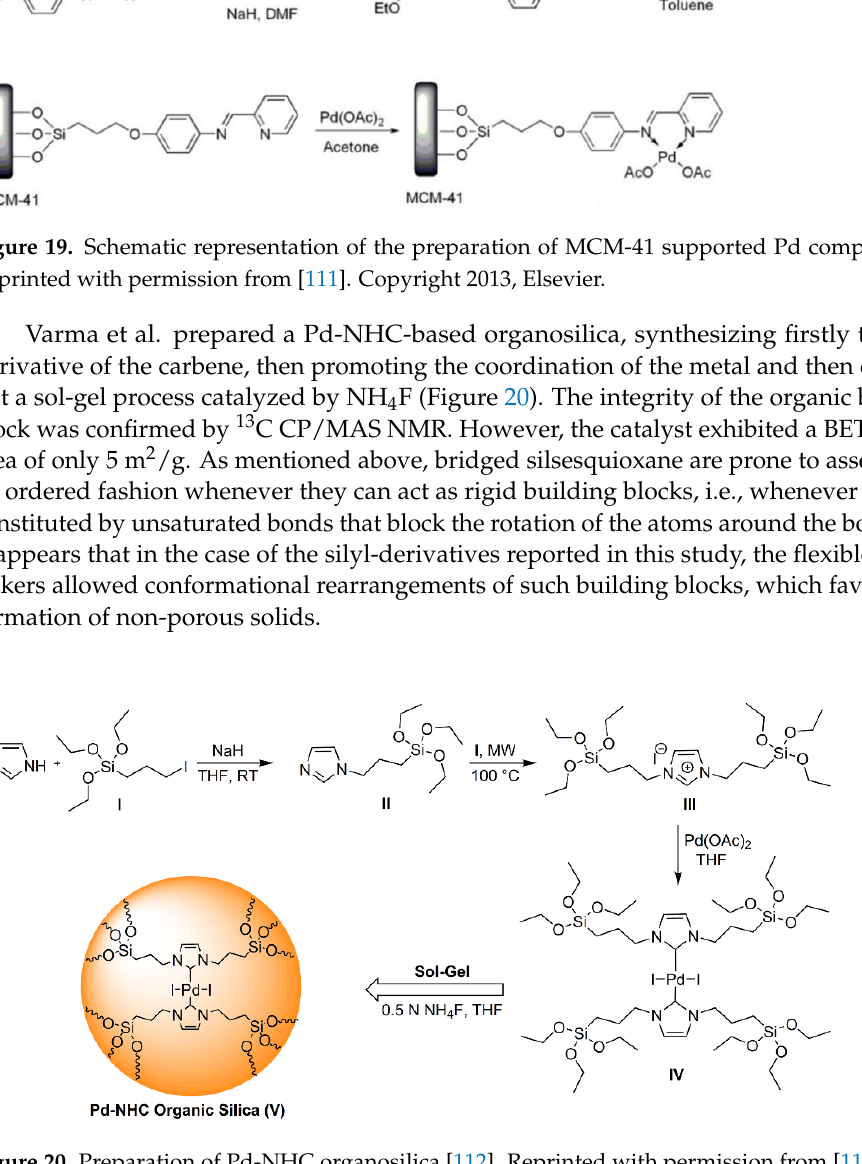
Figure 21. Schematic representation of the synthesis of silica-supported chiral Ru complexes [113]. Reprinted with permission from [113]. Copyright 2011, Royal Society of Chemistry.